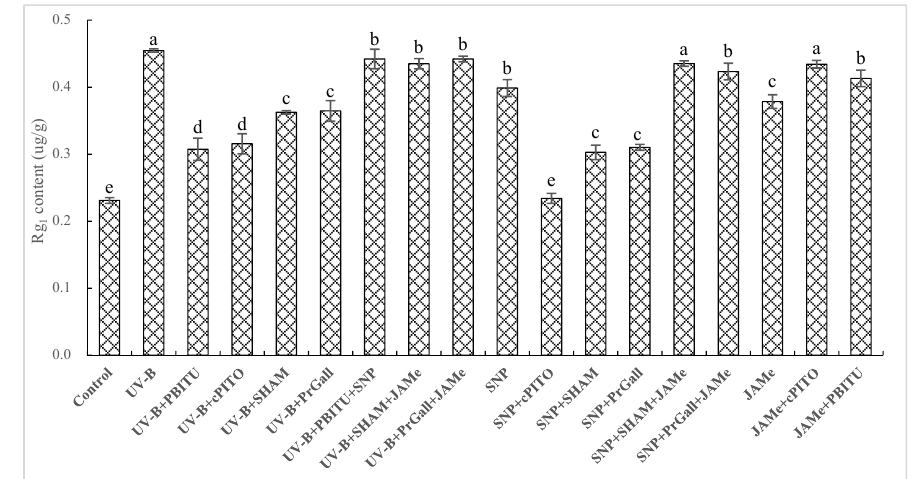
Figure 4. E ff ects of inhibitors on the UV-B-induced Rg 1 production of P. quinquefolius roots. The roots treated with UV-B irradiation and inhibitors were harvested at 24 h after UV-B irradiation, and Rg 1 production was then determined. Inhibitors were pretreated 1 h before UV-B irradiation. The control received the vehicle solvent only. Data are means of three replicates ± SD. Di ff erent letters indicate significantly di ff erent values according to one-way ANOVA followed by Student–Newman–Keuls tests ( p < 0.05).